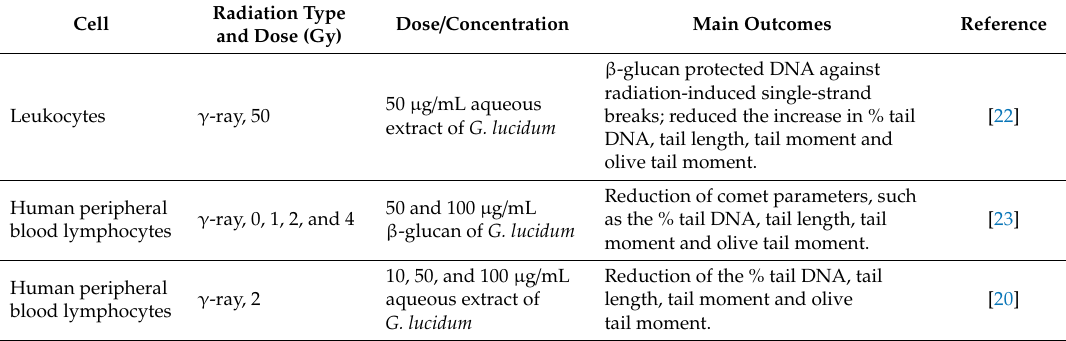
Table 2. Summary of articles focused on the ex vivo radioprotective e ff ect of G. lucidum included in the systematic review.